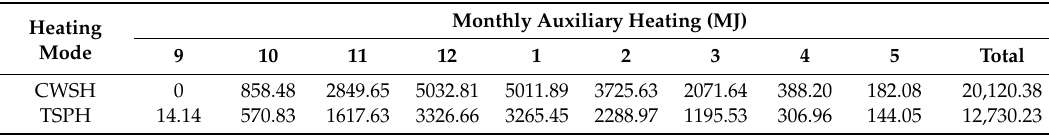
Table 6. Comparison of auxiliary heating of two